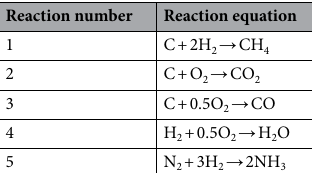
Table 3. Chemical reaction considered in the combustor 63 .